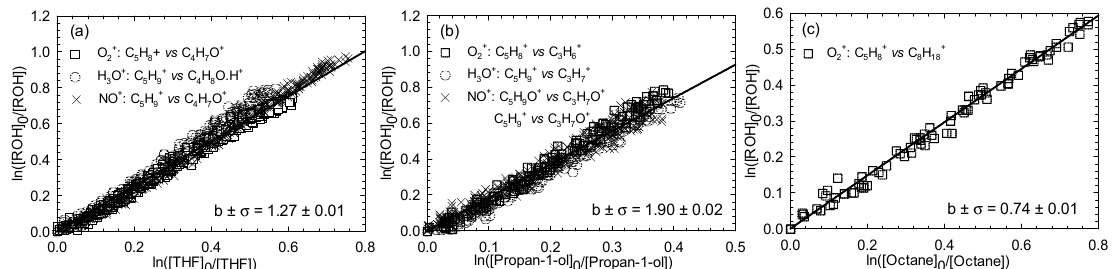
Figure 1. Relative loss of ( Z )-2-penten-1-ol vs. that of tetrahydrofuran (THF) ( a ), propan-1-ol ( b ), and octane ( c ) in the Cl atom-initiated reaction.